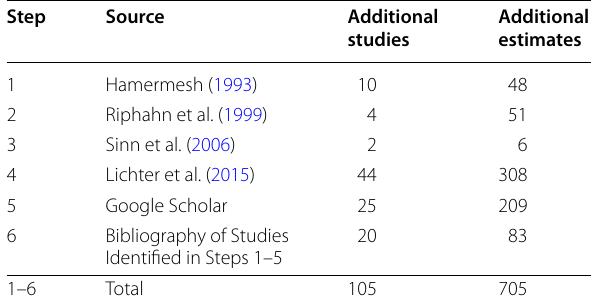
Table 1 Construction of